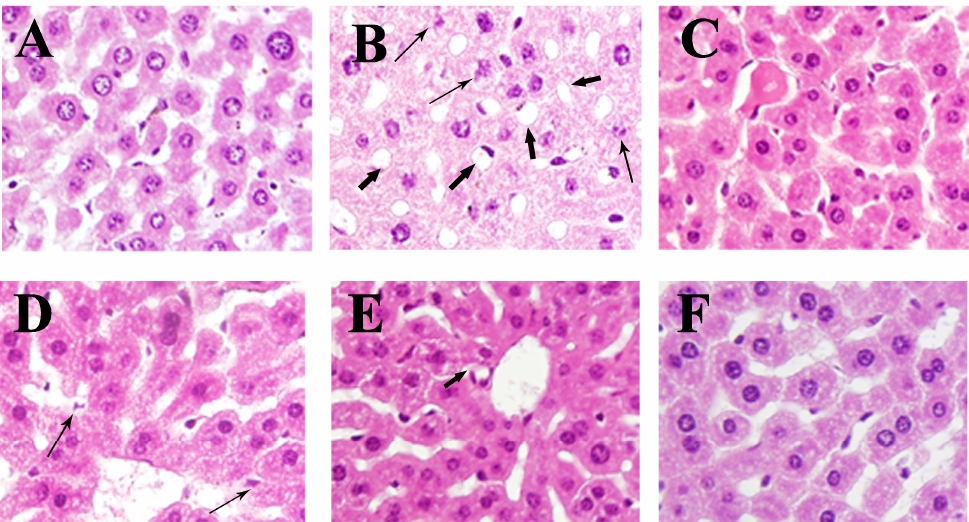
Figure 5. Effects of En-OPS on hepatic cells in liver tissue of alcohol-intoxicated mice. ( A ) normal control groups; ( B ) model control groups; ( C ) positive control groups; and ( D – F ) groups treated with 200, 400, and 800 mg/kg En-OPS (magnification 400×). Cellular degeneration ( ), lipid droplet accumulation ( ).